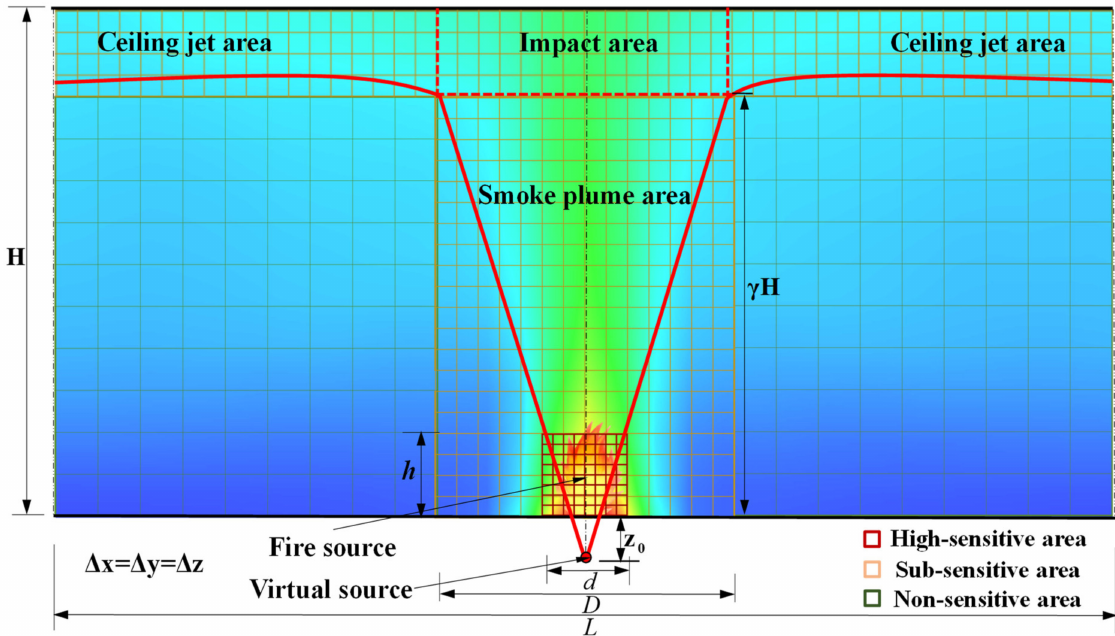
Figure 10. Schematic diagram of temperature distribution, partition and grid division in a large-space fire. Considering the correlation between calculation accuracy and grid sensitivity in different areas of the space, the space is divided into three areas: the highly sensitive area, sub-sensitive area, and non-sensitive area. The highly sensitive area is the fire source area; the sub-sensitive area is the fire-affected area; the non-sensitive area is the other areas of the space. The parameter values for dividing the space area are summarized in Table 2. Each area is uniformly divided by a type of grid size, as shown in Figure 10. The fine enough uniform multi-grid has been applied to simulate the fire development for all design simulation conditions, as shown in Table 3. The simulated duration is 2 h and the time step is 10 s. The number of grids and computing time for all simulation conditions are summarized in detail in Appendix A. Two sets of thermocouple trees are arranged at the center line of the plume area and near and parallel to the ceiling jet area to record the temperature–time curve of each point in the large-space structure, as shown in Figure